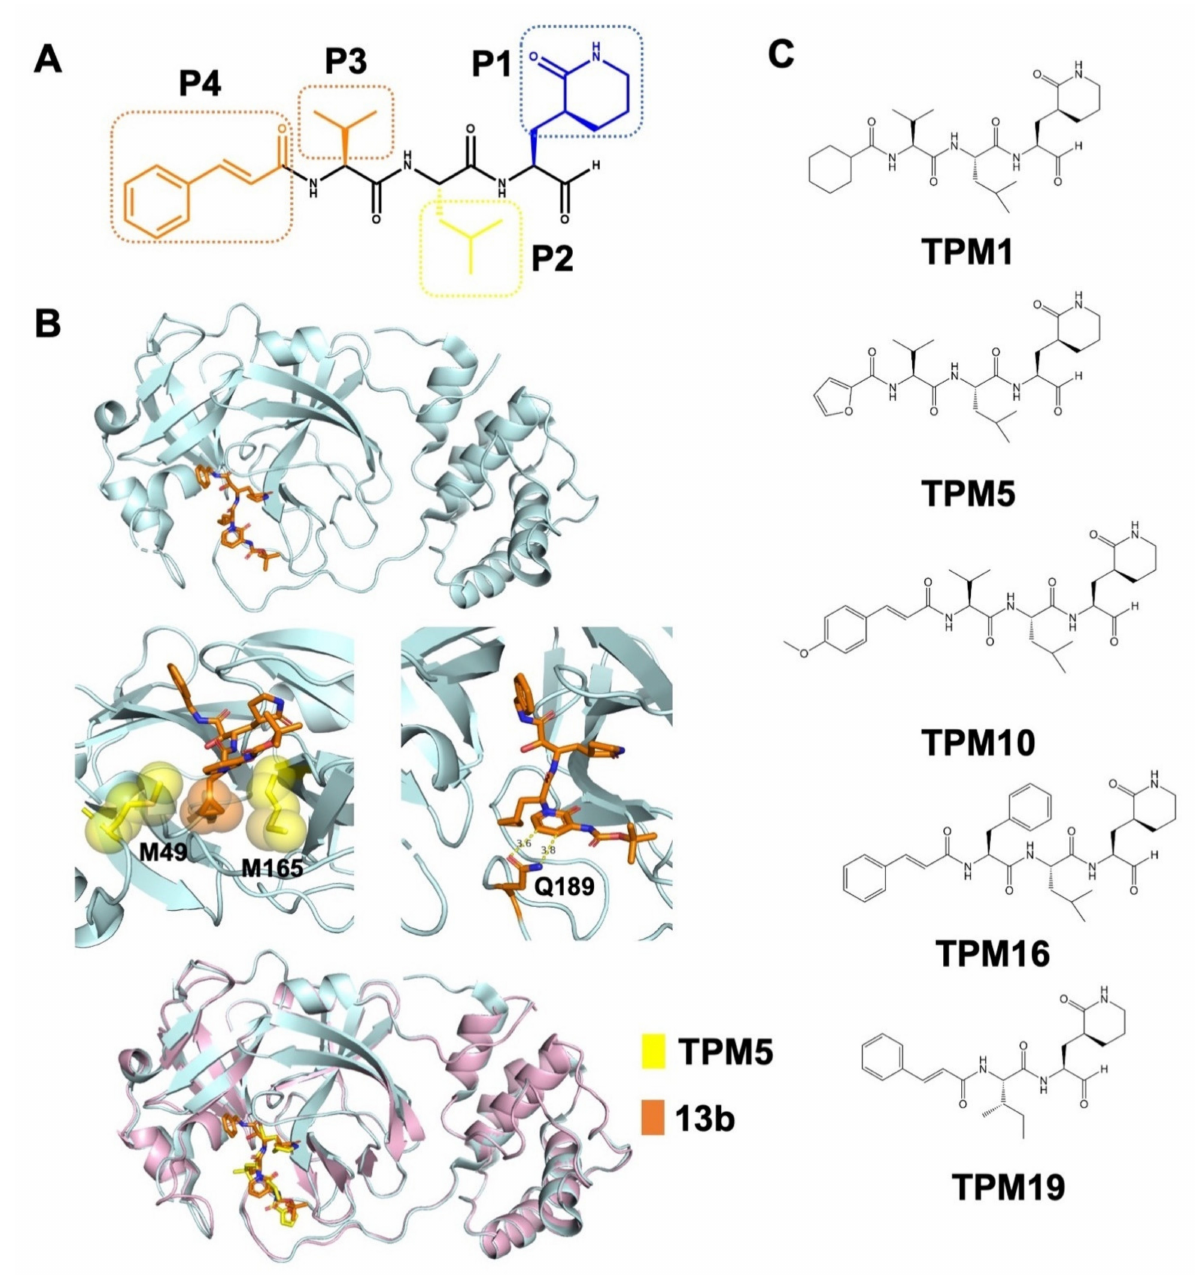
Figure 2. Rational design of peptidomimetic molecules as SARS-CoV-2 3CL Pro inhibitors. ( A ) Scheme of the TPM design with the P1–P4 chemical groups labeled (the chemical structural formula of TPM16 was shown as an example). ( B ) Structural model of the lead compound 13b bound with 3CL Pro (PDB ID: 6Y2F). The interactions between the P2 cyclopropyl group and the M49/M165 residues and the interactions between the P3 pyridone ring and the Q189 residue are illustrated in the middle panel (van der Waals interactions represented as spheres). 13b and TPM bound 3CL Pro with similar modes in the superimposed model (lower panel). ( C ) Chemical structures of TPM1, 5, 10, 16, and